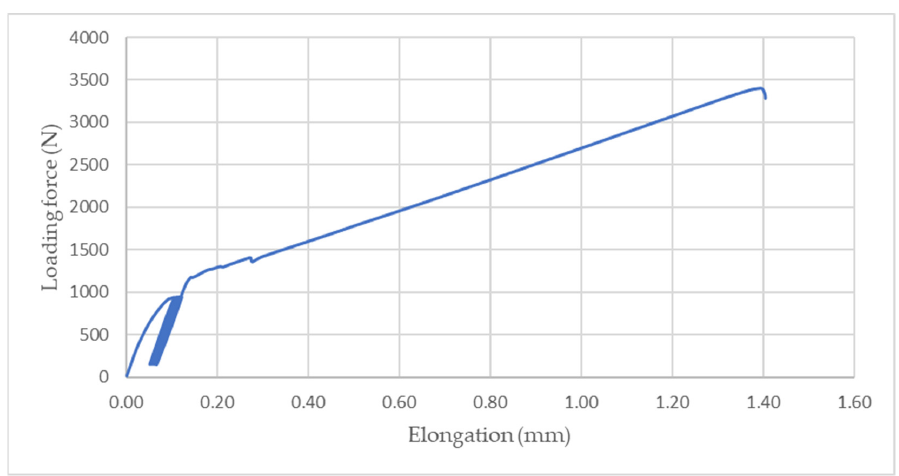
Figure 8. Quasi-static curve of adhesive bond AB10 at cyclic loading intensity 5–30%.